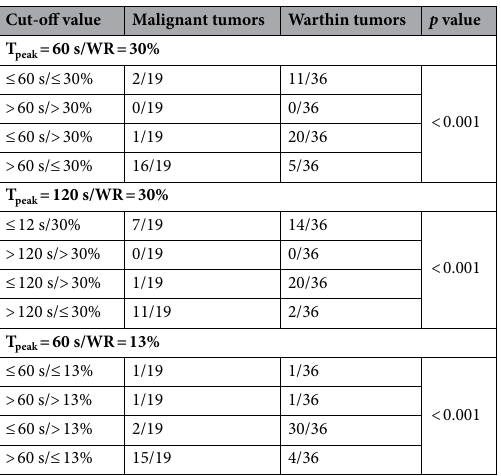
Table 4. Frequency of identifying parotid lesions as Warthin tumors and malignant tumors depending on the type of TIC defined on the basis of the cut-off values for T peak and WR.